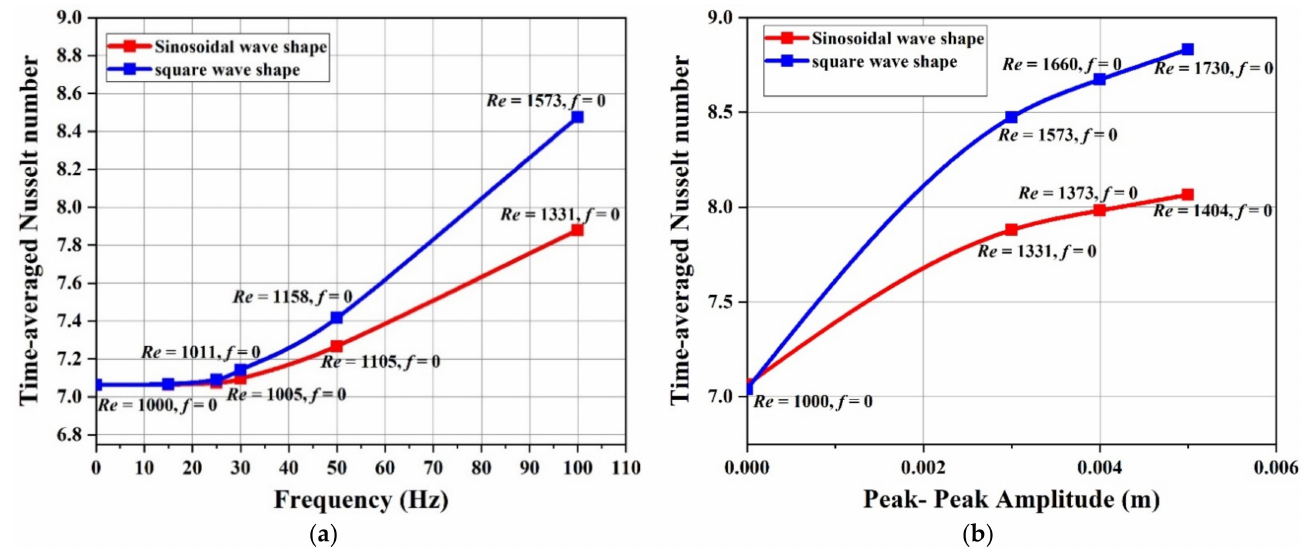
Figure 10. Variation in time-averaged Nusselt number with vibrational parameters and corresponding Reynolds number under nonvibrating conditions: ( a ) frequency at constant Amp = 0.003 m and Re = 1000; ( b ) peak-to-peak amplitude at constant f = 100 Hz and Re =